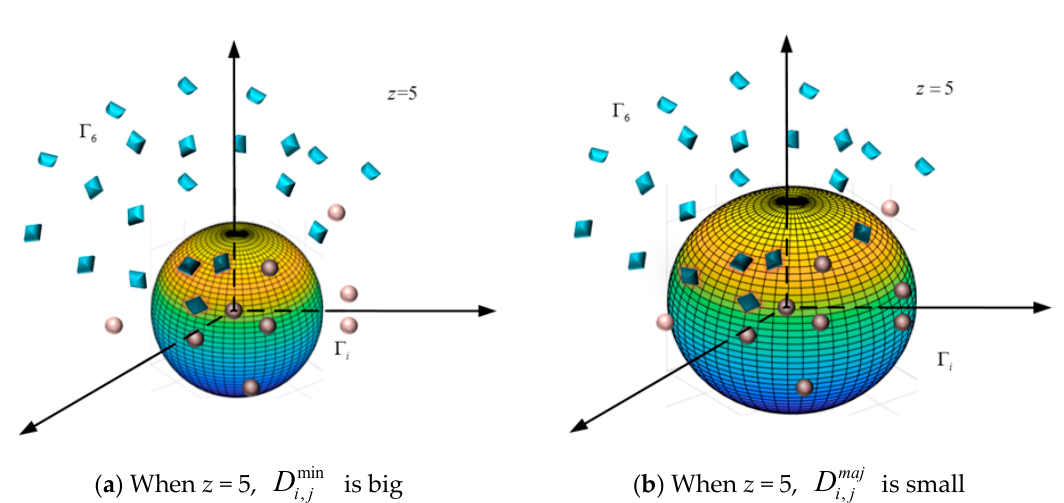
min D is bigger and is , i j